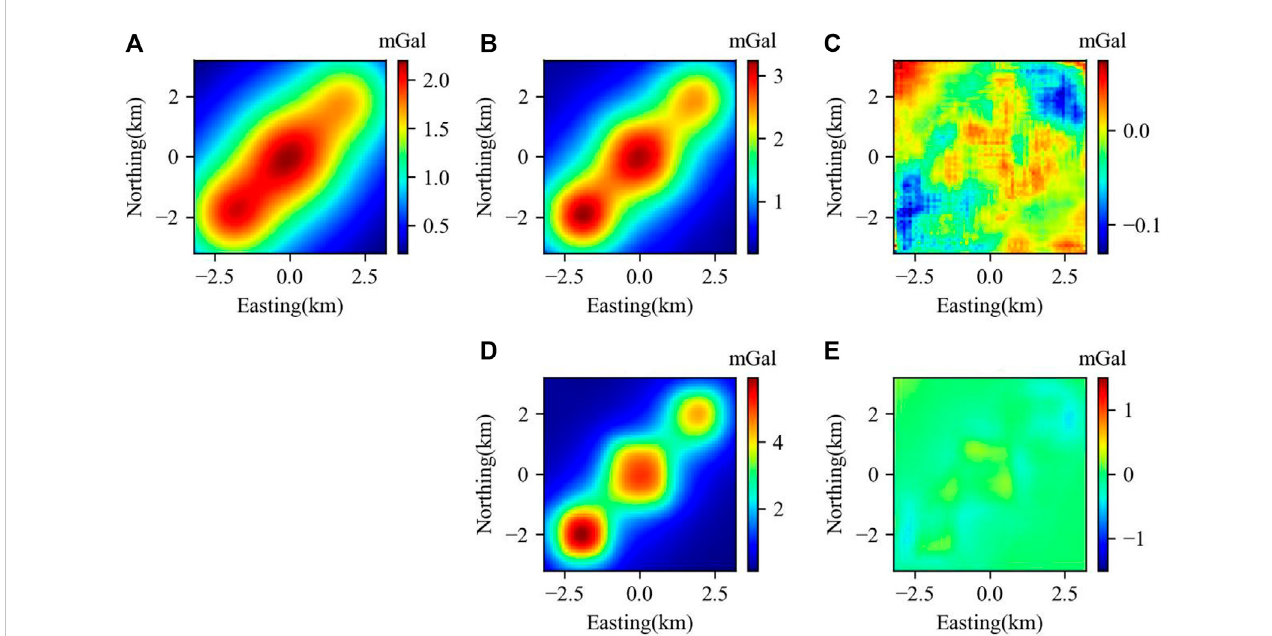
FIGURE 7 Twice DC operation: (A) gravity anomaly at 1,000 m; (B) gravity anomaly at 500 m, calculated by the once DC operation; (C) the error between the predicted gravity anomaly and the true gravity anomaly at 500 m; (D) gravity anomaly at 0 m, calculated by the twice DC operation; (E) error between the predictedgravityanomalyandthetruegravityanomalyat0 m.Thetruegravityat500 misshowninFigure6A,andthetruegravityanomalyat0 misshownin Figure 5B.